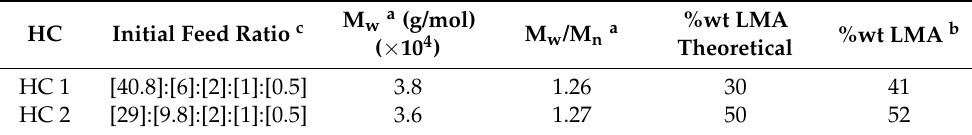
Table 1. Molecular characteristics of the synthesized